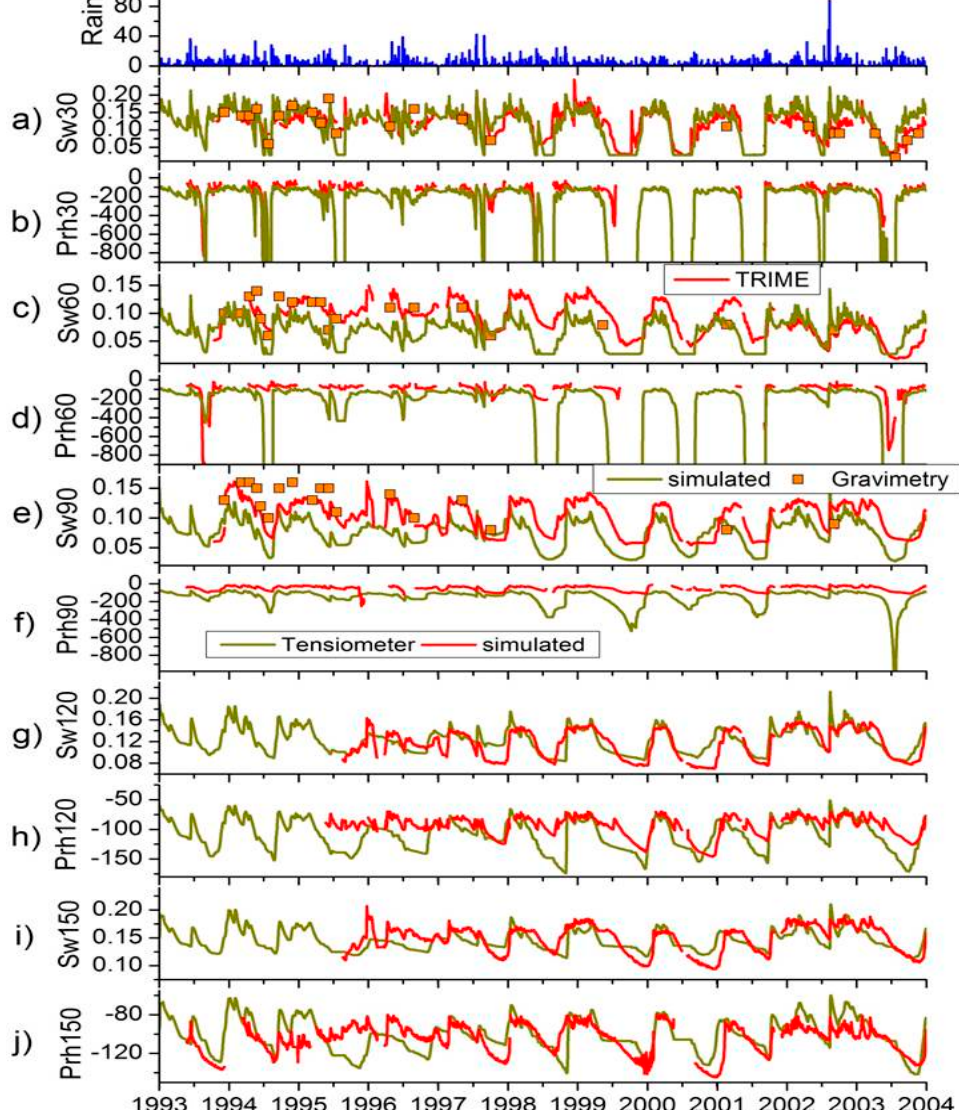
Figure 9. Daily rainfall (Rain) in mm d − 1 , simulated and measured soil water contents (TRIME, Gravimetry) in cm 3 cm − 3 at soil compartments 0–30 cm ( a , Sw30), 30–60 cm ( c , Sw60), 60–90 cm ( e , Sw90), 90–120 cm ( g , Sw120), and 120–150 cm depth ( i , Sw150) and pressure heads in hPa at 30 cm ( b , Prh30), 60 cm ( d , Prh60), 90 cm ( f , Prh90), 120 cm ( h , Prh120) and 150 cm depth ( j , Prh150), Plot 3,